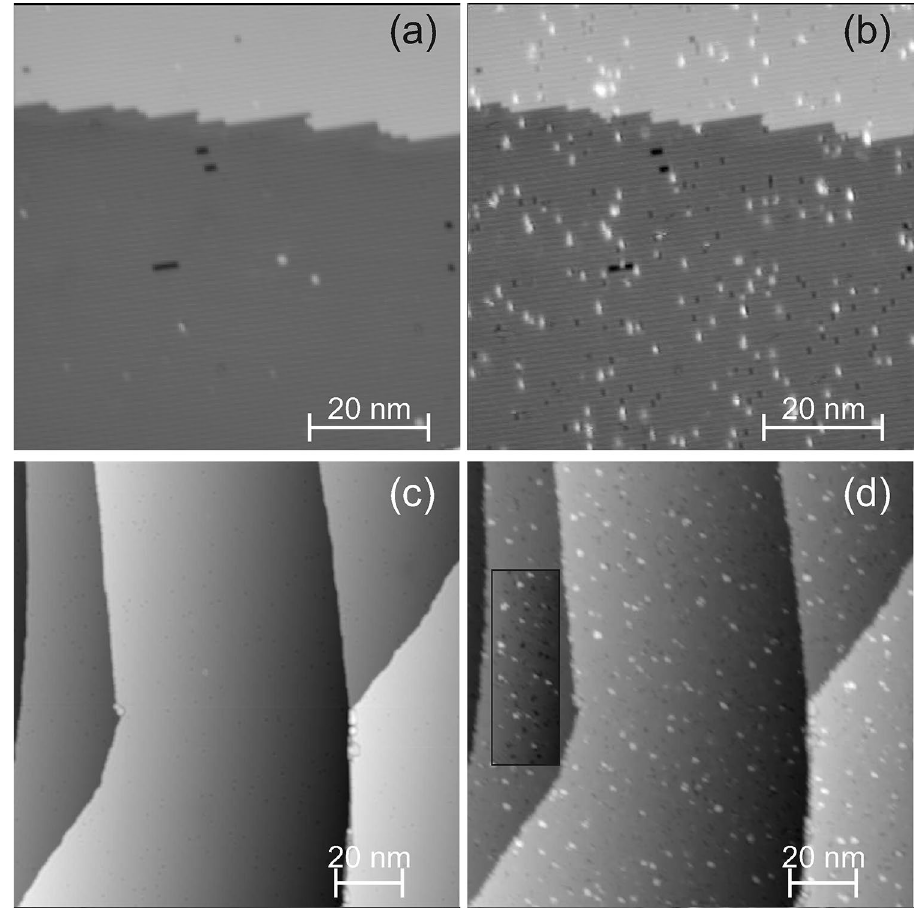
Figure 10. Effect of low-intensity laser illumination on Cu surfaces: ( a , b ) STM images of Cu(511) before ( a ) and after ( b ) illumination at an absorbed SPP fluence of 0.2 mJ/cm 2 , 10 6 laser pulses, − 200 mV ( a ) 500 pA, and ( b ) 10 pA ( c , d ) STM images of Cu(111) before ( c ) and after ( d ) illumination at an absorbed SPP fluence below 5 mJ/cm 2 , 10 7 laser pulses, 228 mV, 100 pA; contrast is increased in